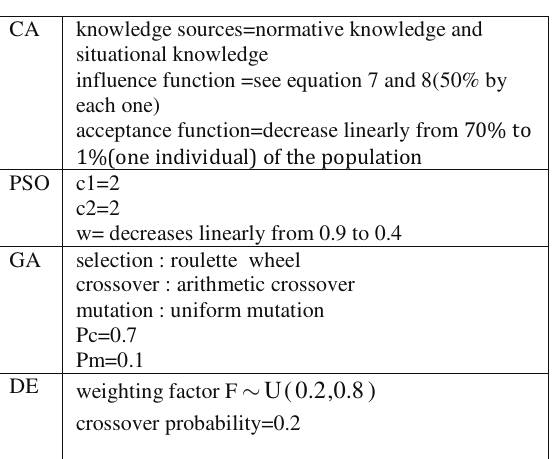
Table 2. detail of all algorithms used in the comparison